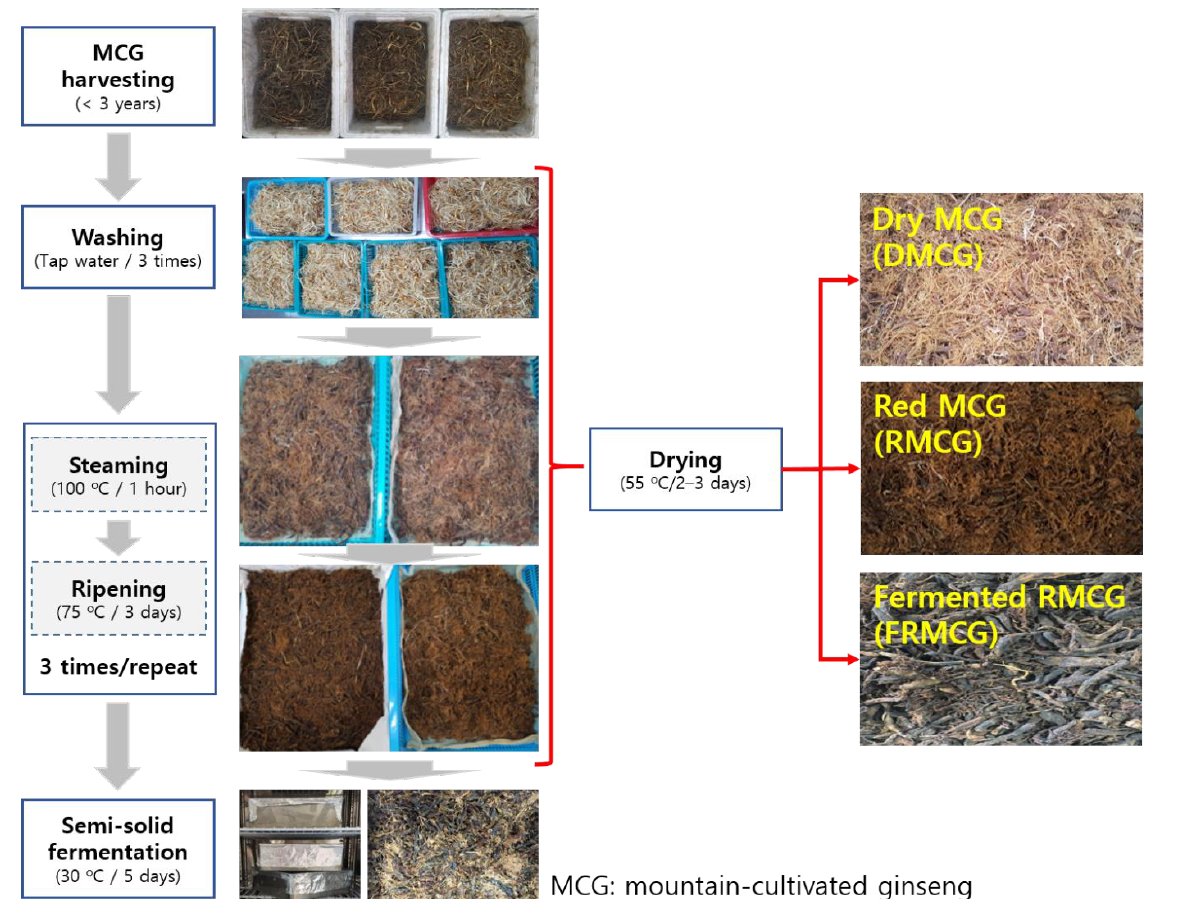
Figure 1. Photograph of food processing steps of mountain-cultivated ginseng. DMCG, dry mountain-cultivated ginseng; RMCG, red mountain-cultivated ginseng; and FRMCG, fermented red mountain-cultivated ginseng.